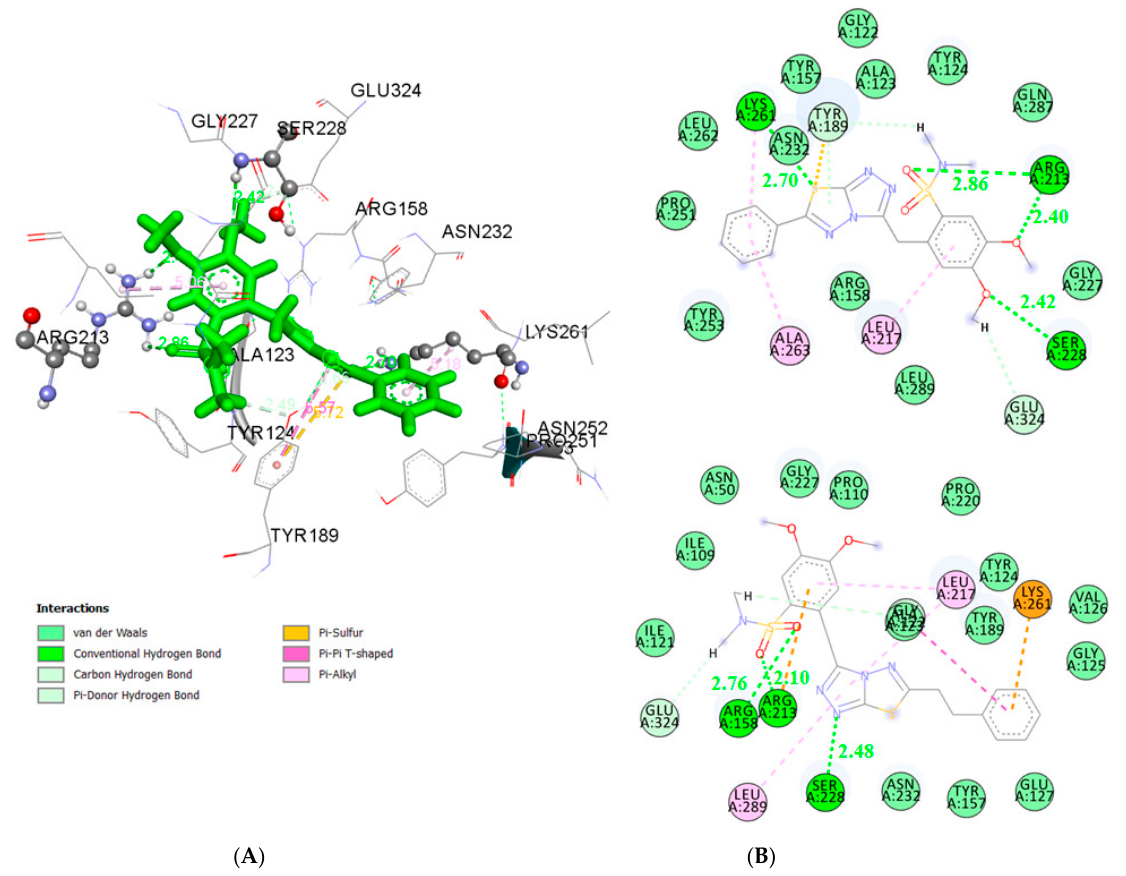
Figure 1. ( A ) Docked conformation of the most active compound 19 in E.coli MurB; ( B ) 2D diagrams of the most active compounds 19 (up) and 3 (down) in E.coli MurB.